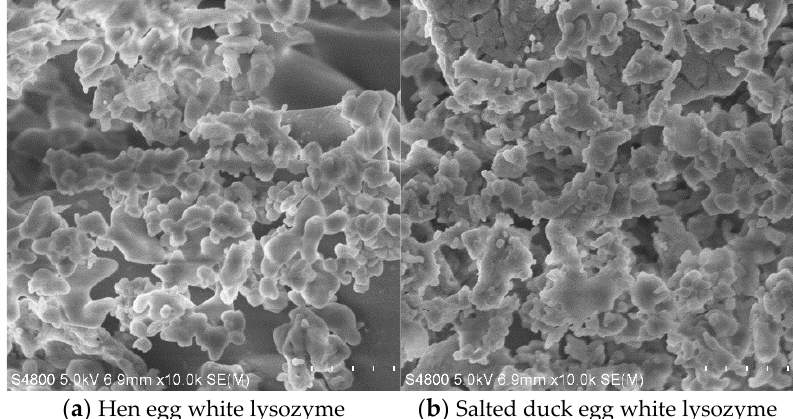
Figure 5. Comparison of lysozyme from hen egg white and SDEW.